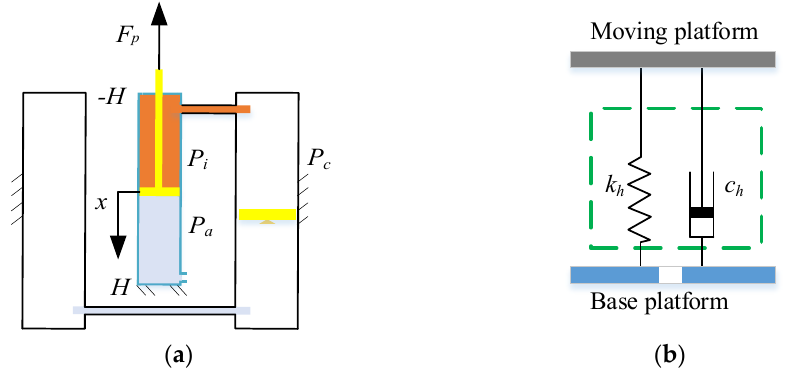
Composition diagram of the compensator Simplified schematic diagram of the compensator Figure 5. Schematic diagram of the Figure 5. Schematic diagram of the compensator.